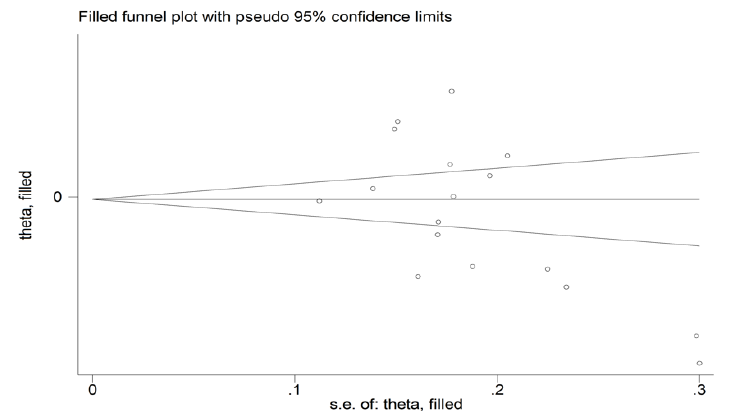
Figure 4. Funnel plot of studies investigating the association between the mean platelet volume and rheumatoid arthritis. Dummy studies and genuine studies are represented by enclosed circles and free circles, respectively.